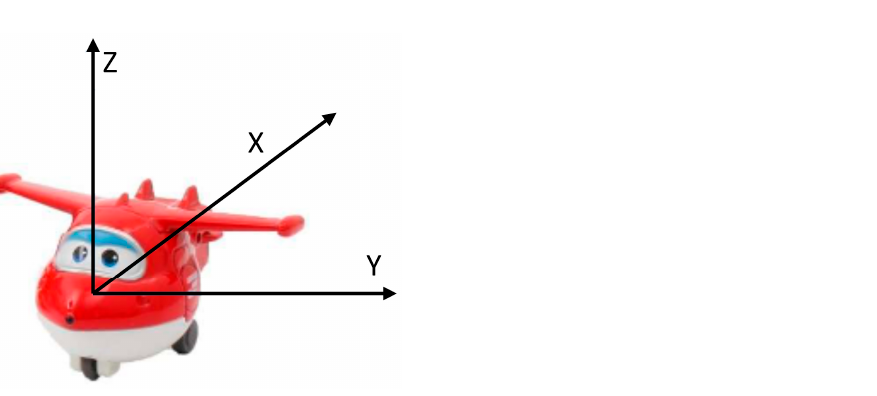
Figure 3. The circuit for battery charging.